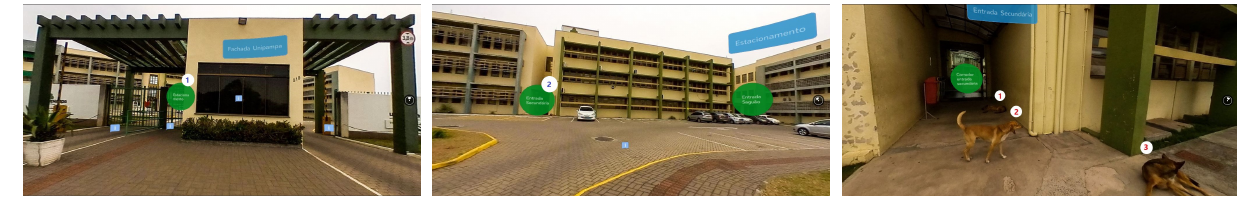
Figure 1. Sequence of scenes in the easy task of the virtual